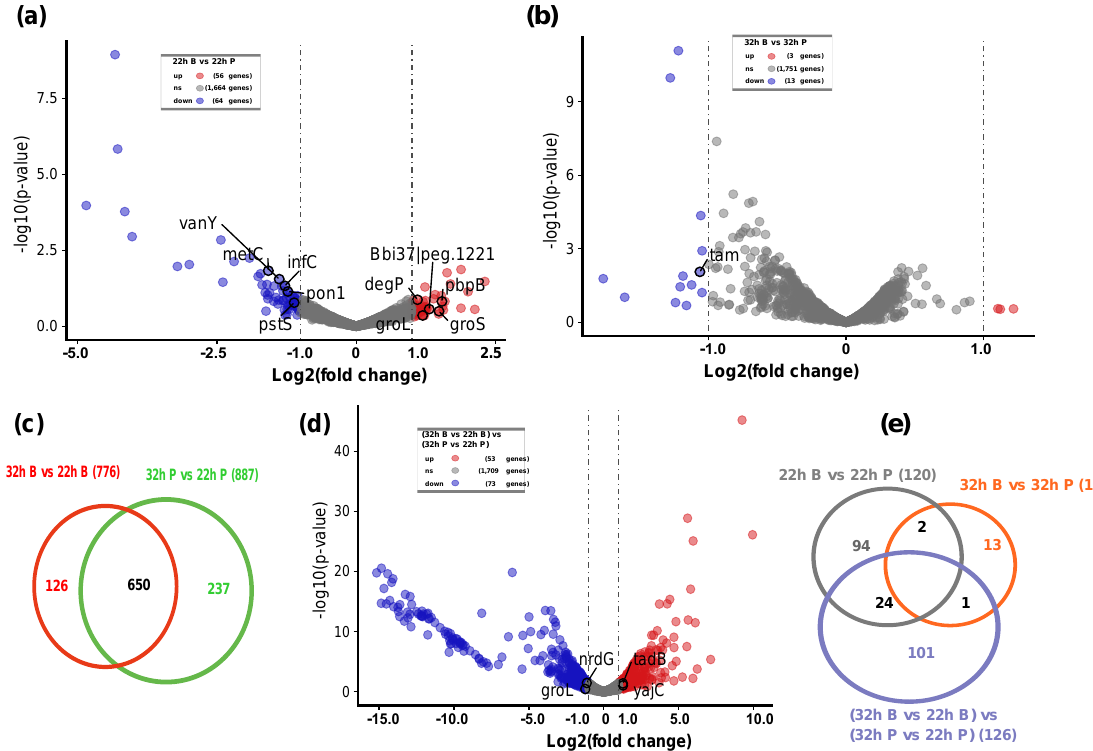
Figure 2. Transcript profiling changes during B. bifidum FHB150 biofilm formation. ( a ) The volcano plot showing the DEGs between 22 h B and 22 h P. DEGs: differentially expressed genes. Red points represent upregulated DEGs and blue points represent downregulated DEGs. B: biofilm cells, the group containing wheat fiber. P: planktonic cells, the control group without wheat fiber. ( b ) The volcano plot showing the DEGs between 32 h B and 32 h P. ( c ) Venn diagram representing the number of DEGs between 32 h B vs. 22 h B and 32 h P vs. 22 h P. ( d ) The volcano plot showing the DEGs changes during biofilm formation (22–32 h). ( e ) Venn diagram representing the number of nonredundant DEGs during biofilm